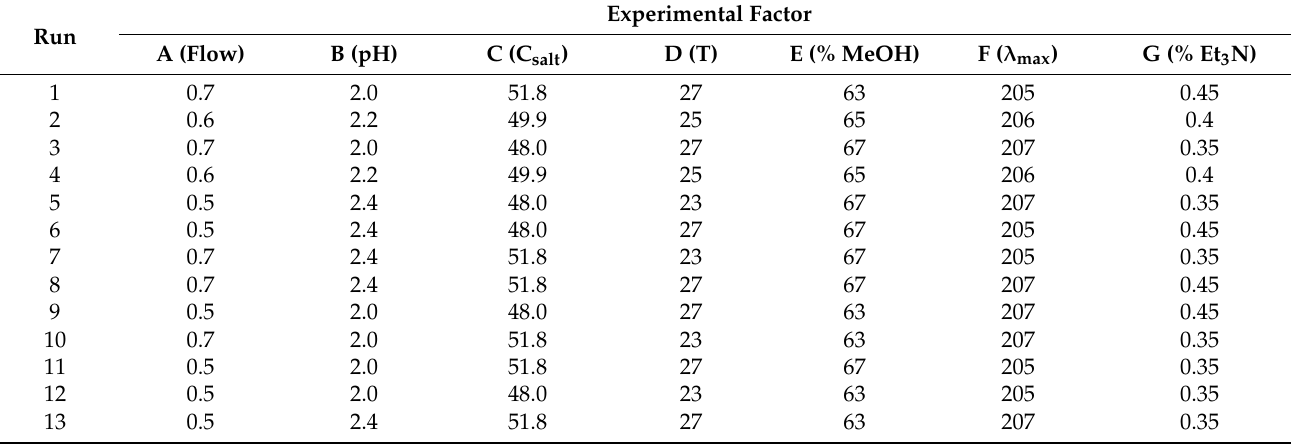
Table 2. Experiments of FFD proposed by Design Expert